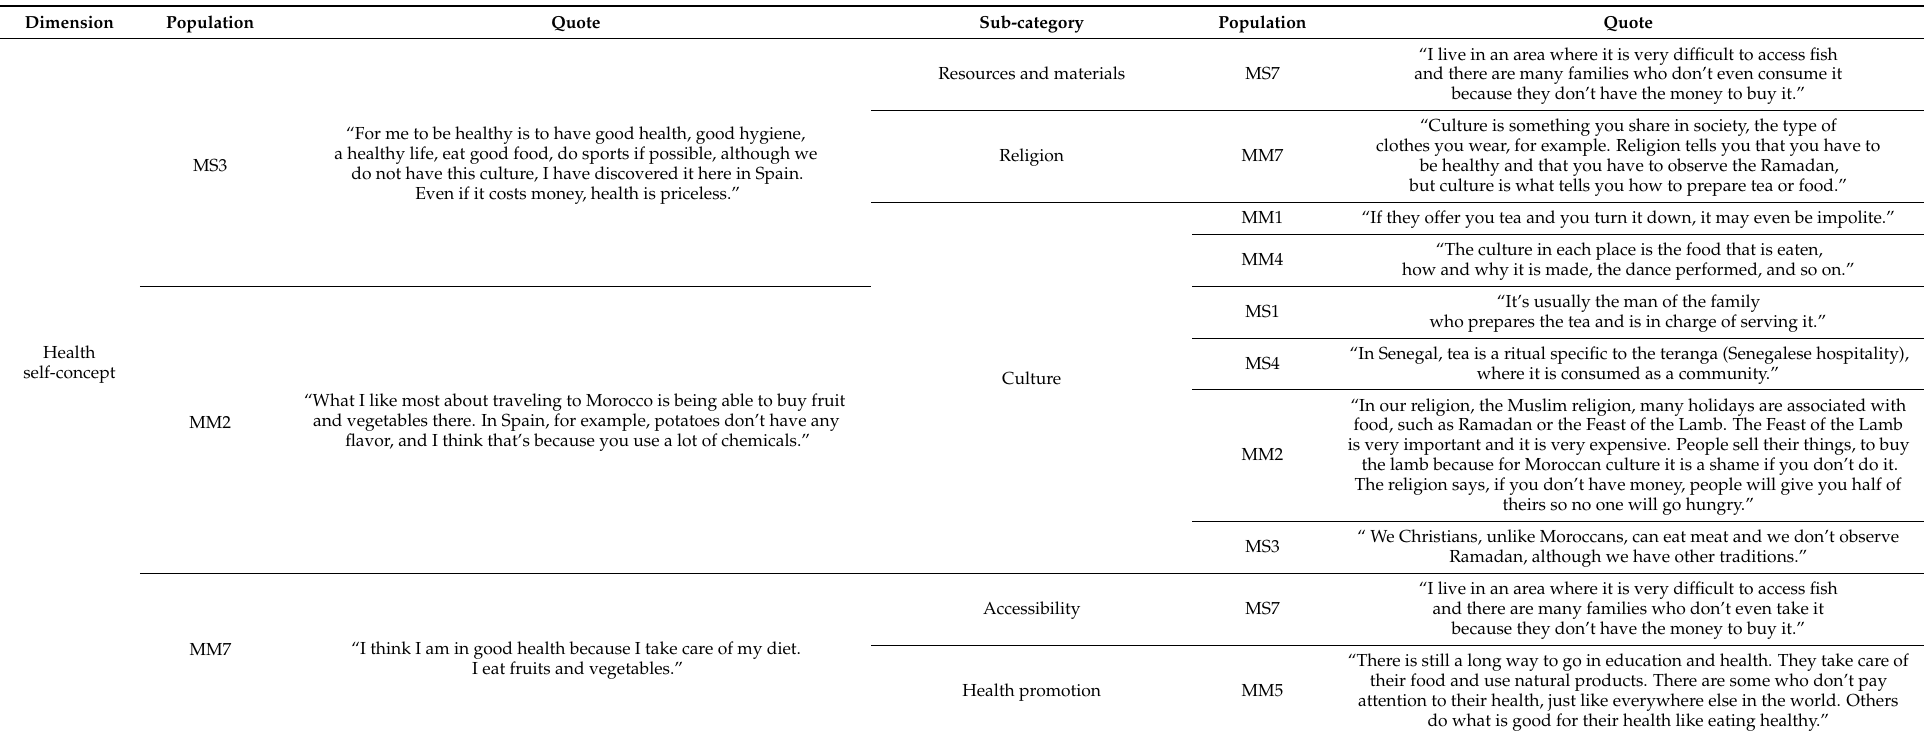
Table 5. Health self-concept: Senegalese and Moroccan women’s